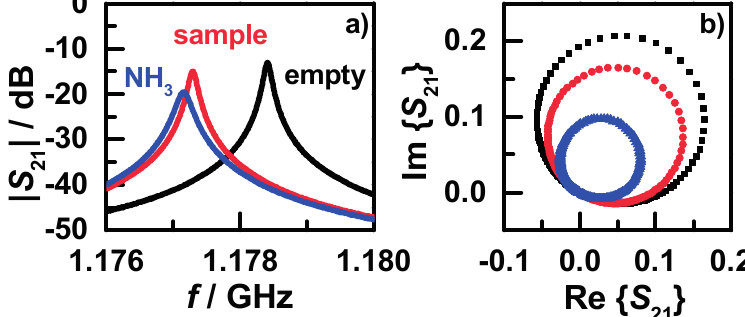
Figure 7. ( a ) Example resonance peaks at 200 °C of the empty sample tube (black), with inserted H-ZSM-5 zeolite sample (red), and the sample loaded with ammonia (blue); ( b ) the corresponding resonance circles.